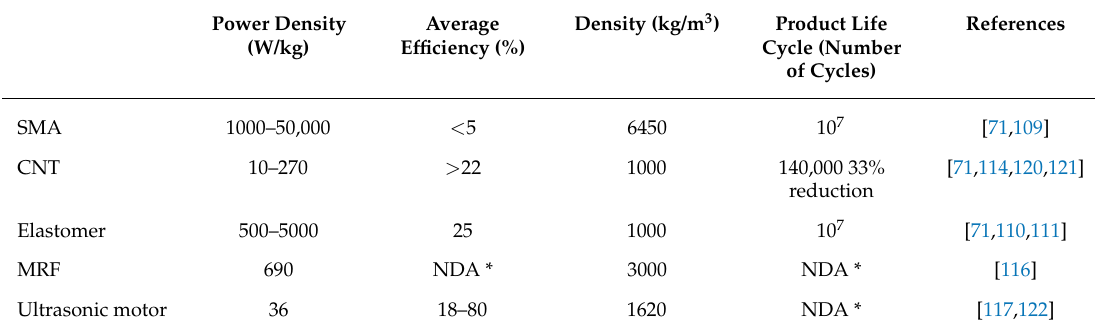
Table 3. Characteristics of unconventional bionic orthosis